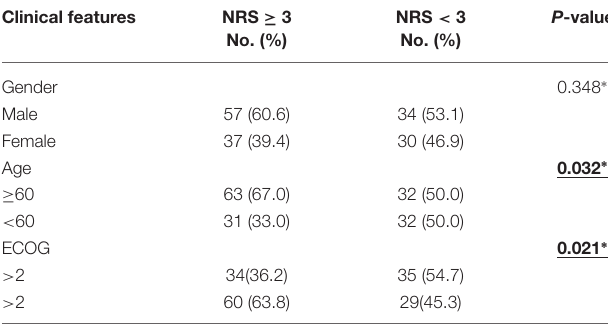
TABLE 2 | Relationship between clinical features and NRS.